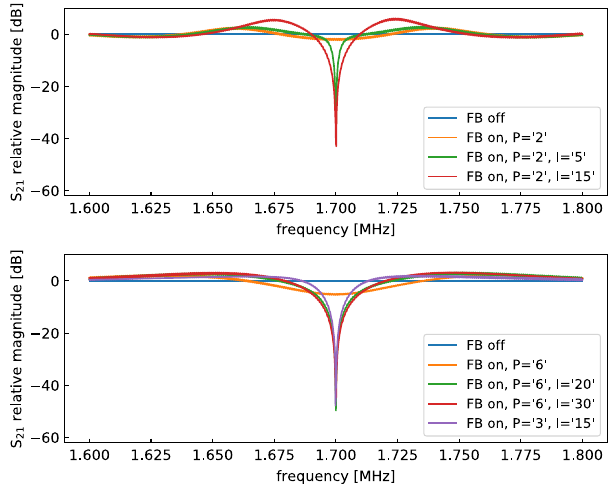
FIG. 19. Normalized closed loop gains with various PI gain settings at 1.7 MHz, in the cases of (top) the five-stage CIC filter and (bottom) the hybrid filter.